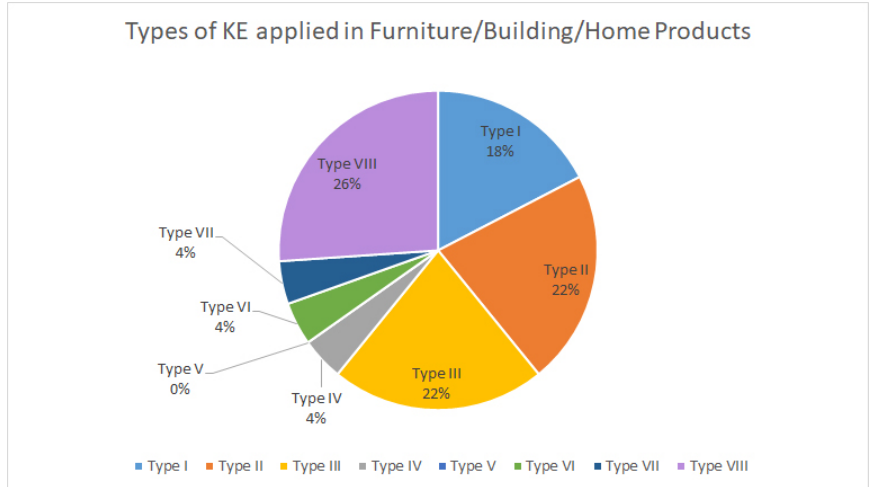
Figure 11. Classification by category of construction-related and household